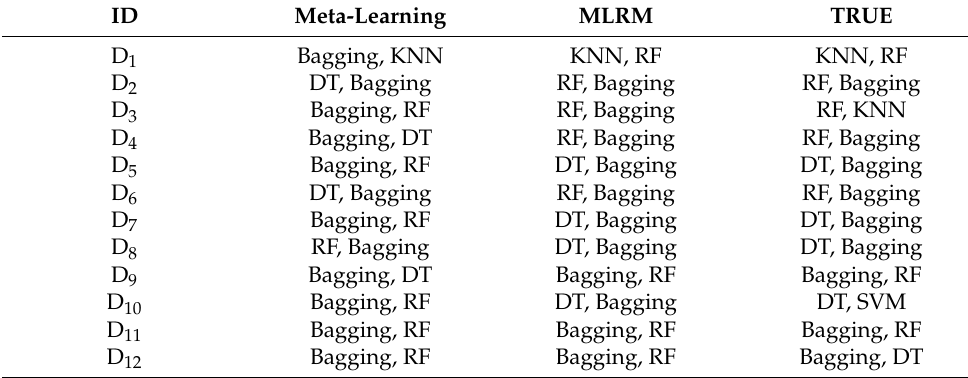
Table 7. Recommendation results between MLRM and meta-learning in all.